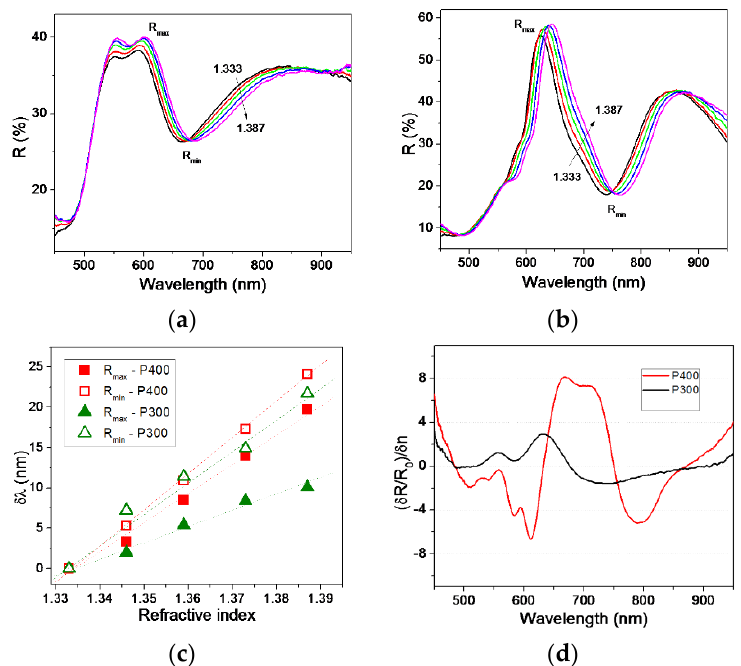
Figure 5. Reflectivity spectra of( a ) array having P = 300 nm, and ( b ) array with P = 400 nm, in liquids of different refractive index. ( c ) Dependence of the shift of different reflectivity maxima/minima on refractive index. ( d ) Relative reflectivity variation per refractive index unit for the two studied nanopost-shell arrays.